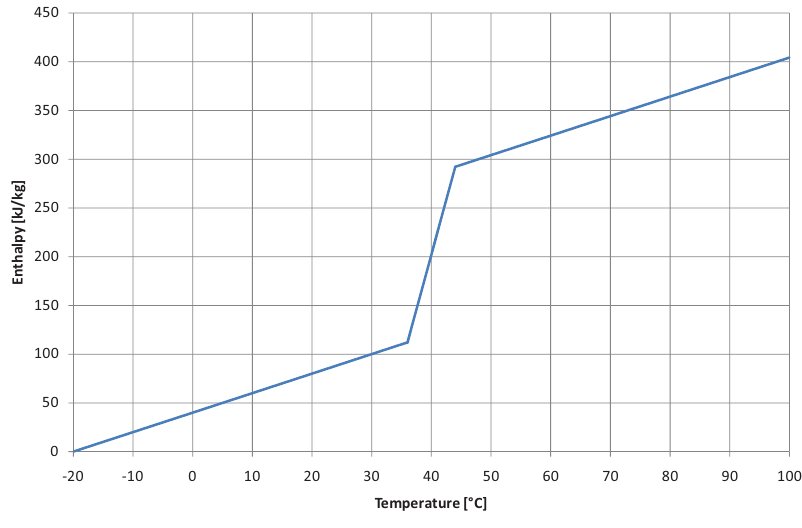
Figure 3: Enthalpy of the